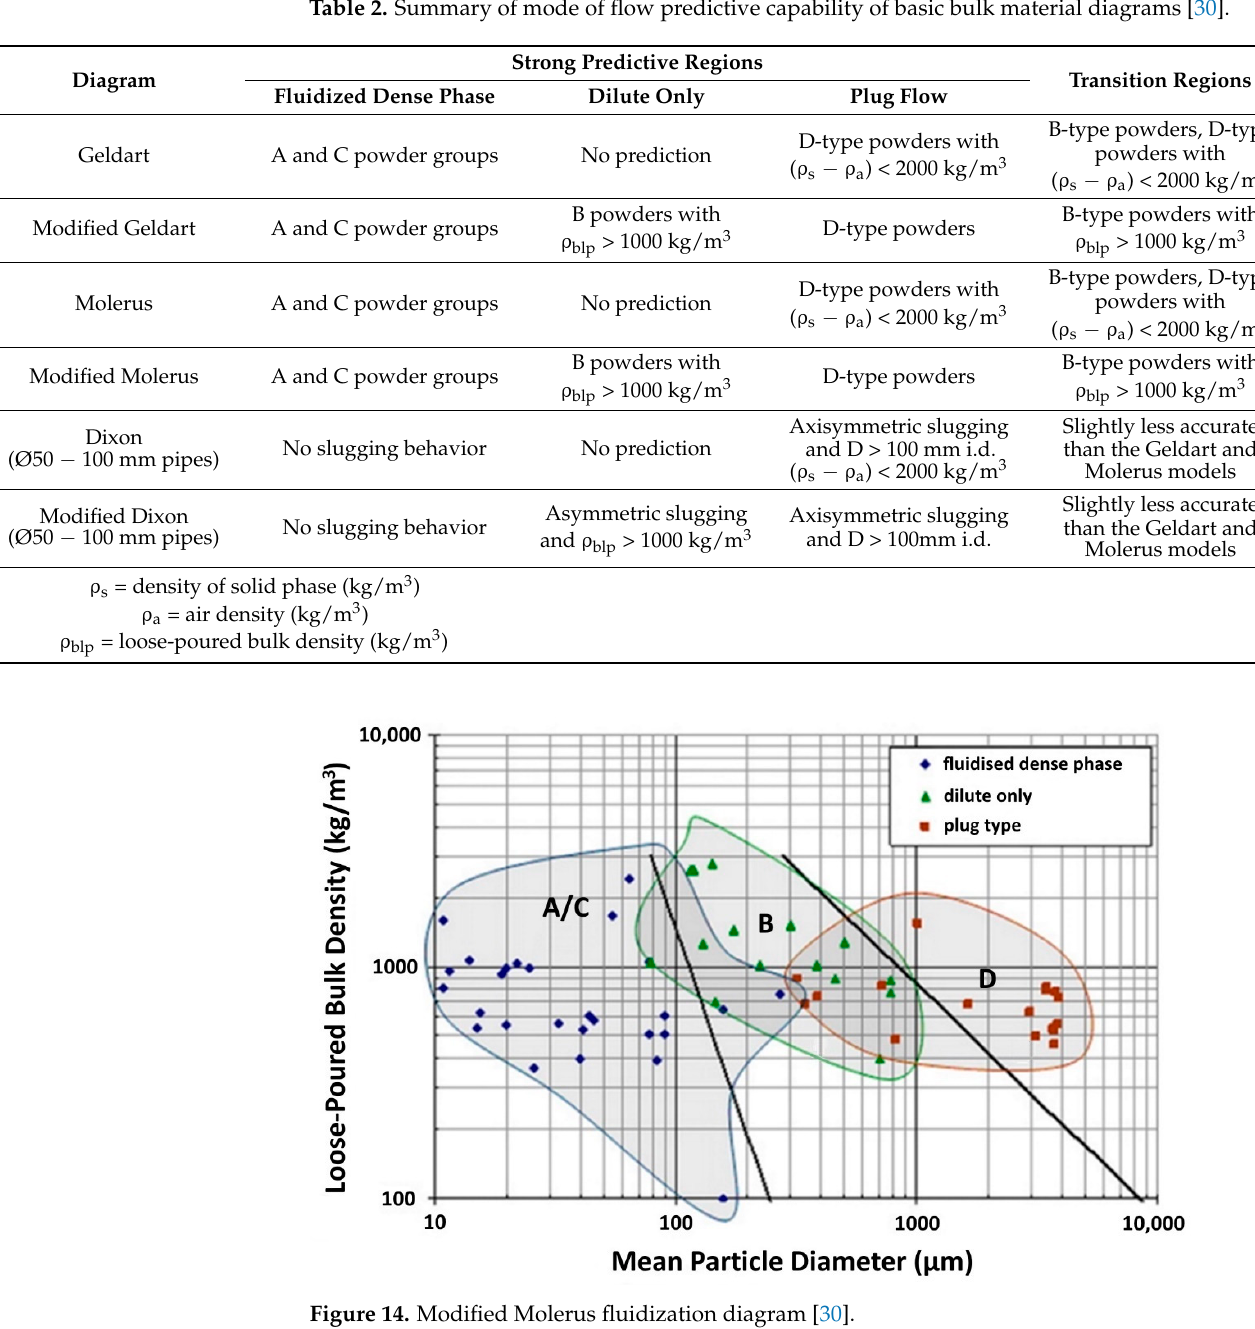
Table 2. Summary of mode of flow predictive capability of basic bulk material diagrams [30].